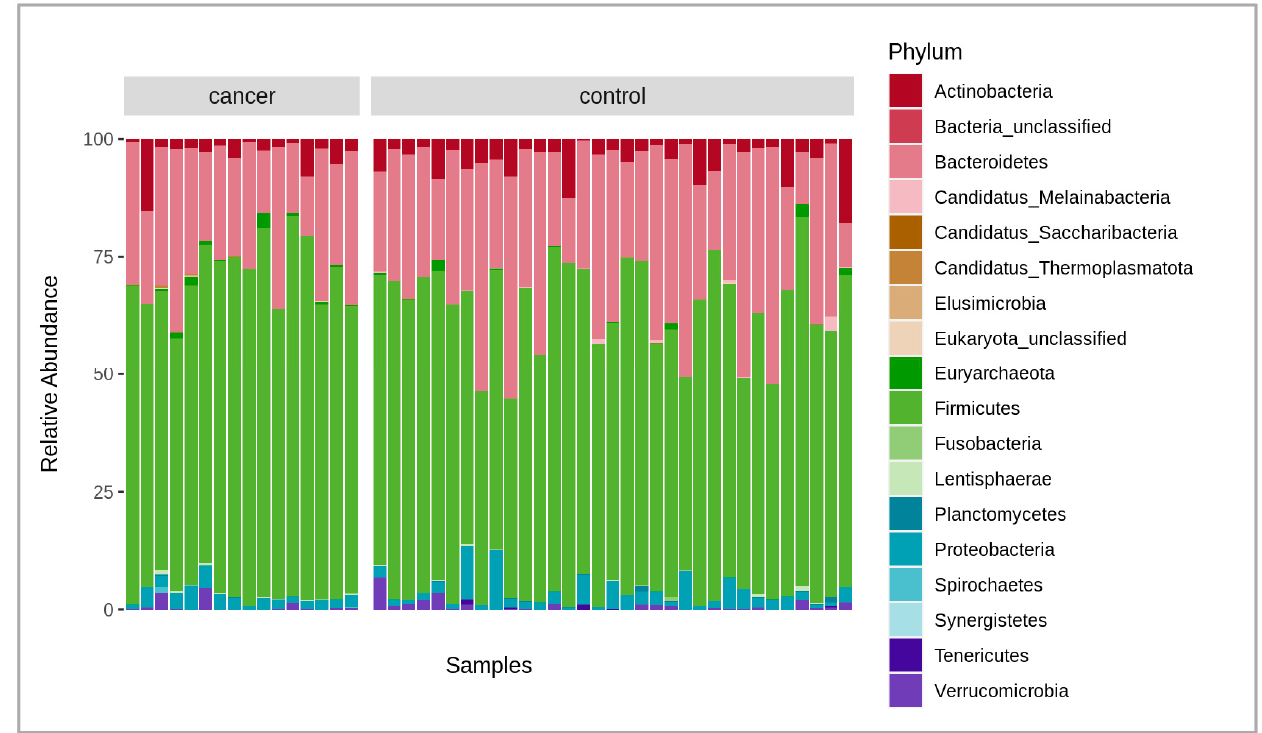
Figure 1. Stacked bar plot of relative abundances of different dominant phyla in both cancer and control groups, where the x -axis represents the samples, and the y -axis, the relative abundance of the phyla.